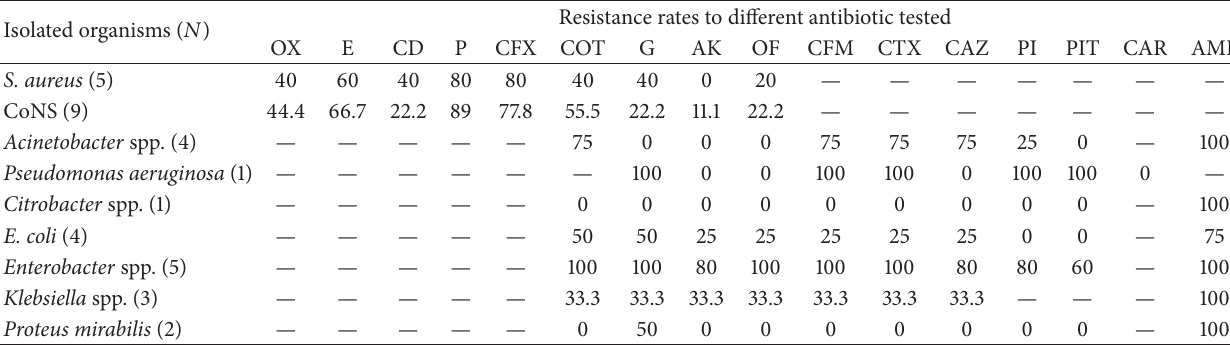
Table 4: Resistant rates of isolates recovered from late-onset septicemia